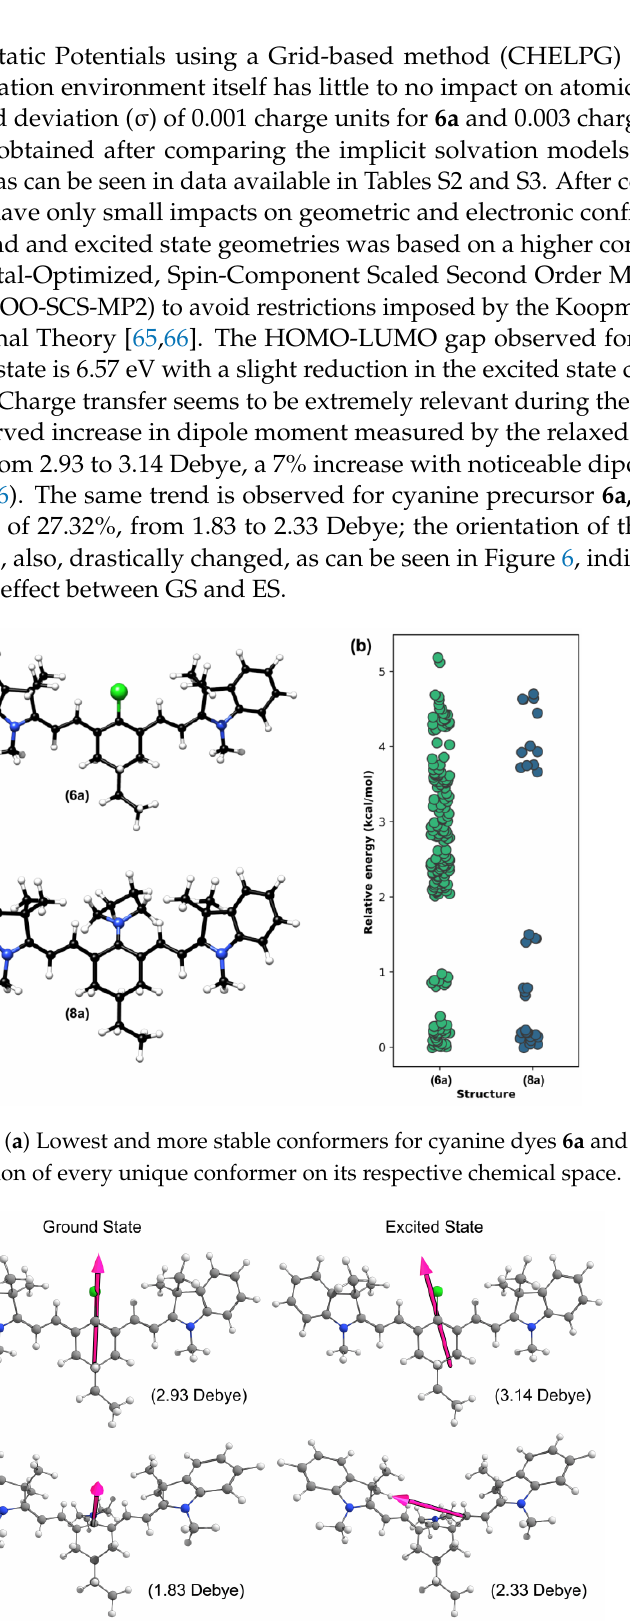
Figure 6. Change in dipole moment between ground and excited state of cyanine dyes 6a ( top ) and 8a ( bottom ). 8a ( bottom